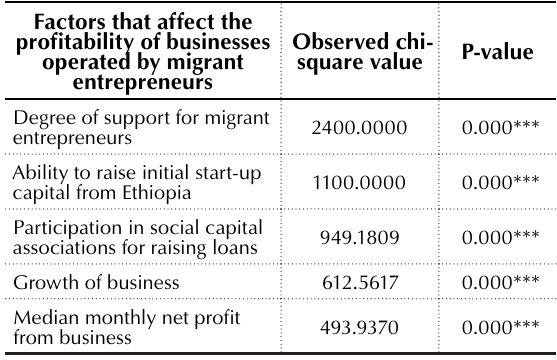
Table 6. Top five significant two-by-two associations from cross-tab analyses ( n =